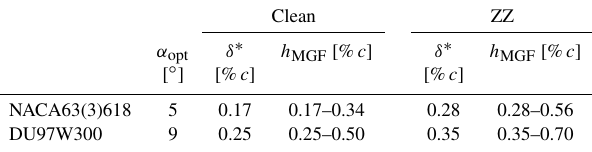
Table 4. XFOIL simulations of the boundary layer displacement thickness and the resulting MGF heights according to Eq.